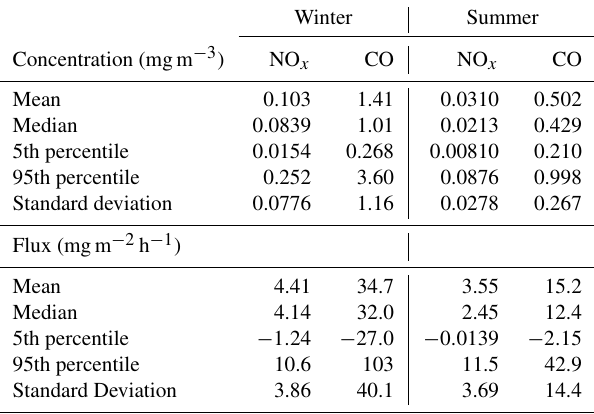
Table 1. Summary table for NO x and CO fluxes and concentrations. Data presented are for fluxes which are within 60% stationarity cri- teria for all u ∗